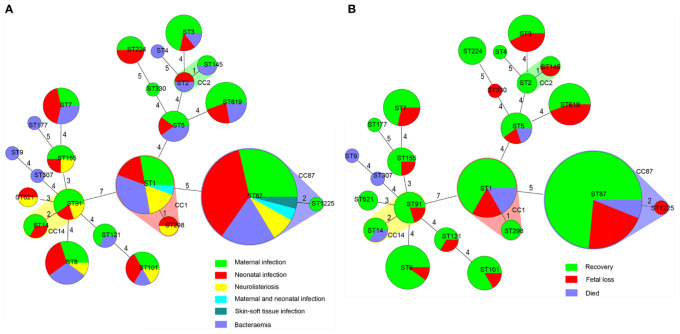
Correlation between sequence type (ST) of L. monocytogenes strains, types as well as outcomes of patients with listeriosis. Minimum spanning tree analysis of L. monocytogenes strains conducted according to ST, demonstrating the relationships among 144 strains collected from patients with listeriosis in 15 cities/provinces. in the minimum spanning tree, the STs are displayed as circles; the size of each circle indicates the number of strains within this particular type. The founder ST was defined as that with the highest number of single-locus variants. STs varying by two alleles in their multilocus sequence typing (MLST) profiles (single-locus variants) are arranged in circles around the primary founder ST. (A) Relationship between infection types of the patients and STs of all 144 L. monocytogenes strains. (B) Relationship between outcomes of the patients and STs of all 144 L. monocytogenes strains.